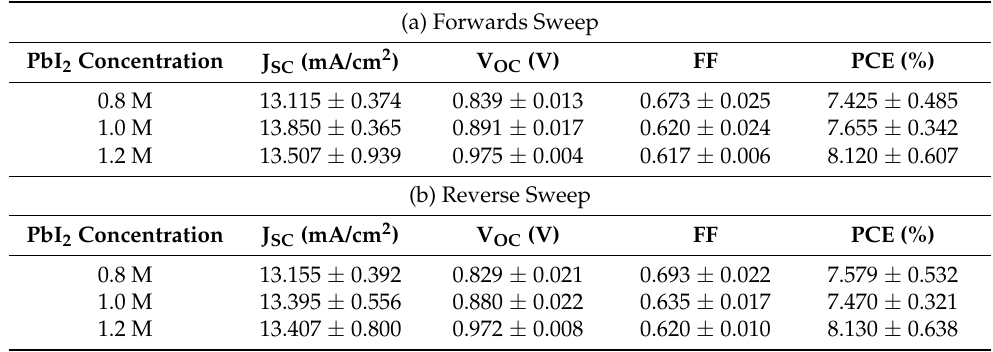
Figure 5. J − V curves under illumination using perovskite active layer prepared using three different PbI 2 concentrations; 0.8 M, 1.0 M and 1.2 M. Table 2. Mean and standard deviations of photovoltaic parameters measured in (a) forward and (b) reverse sweep for the PSCs prepared from different PbI 2 concentration.